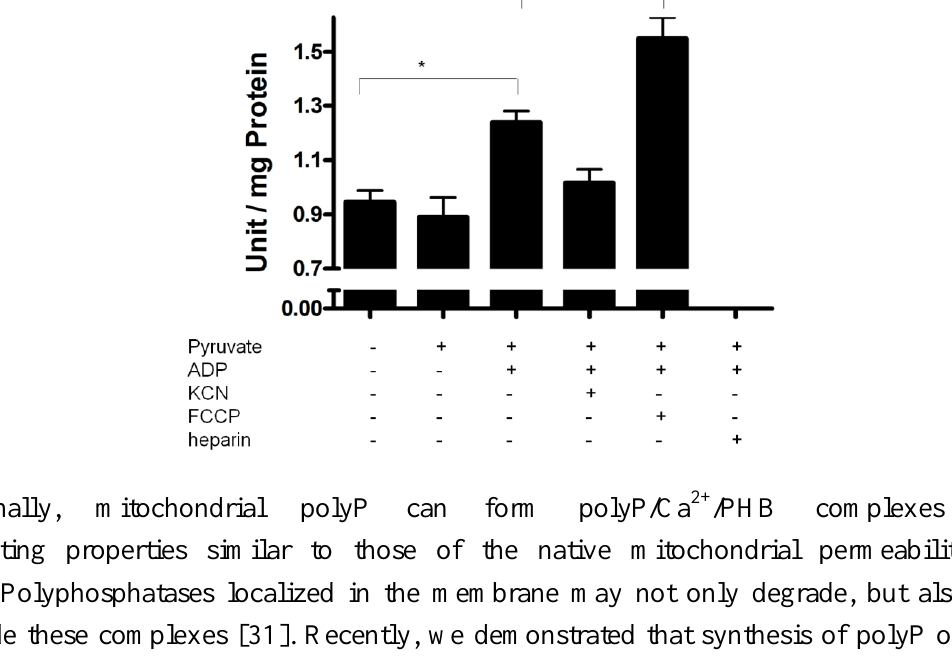
as PPX substrate, 3